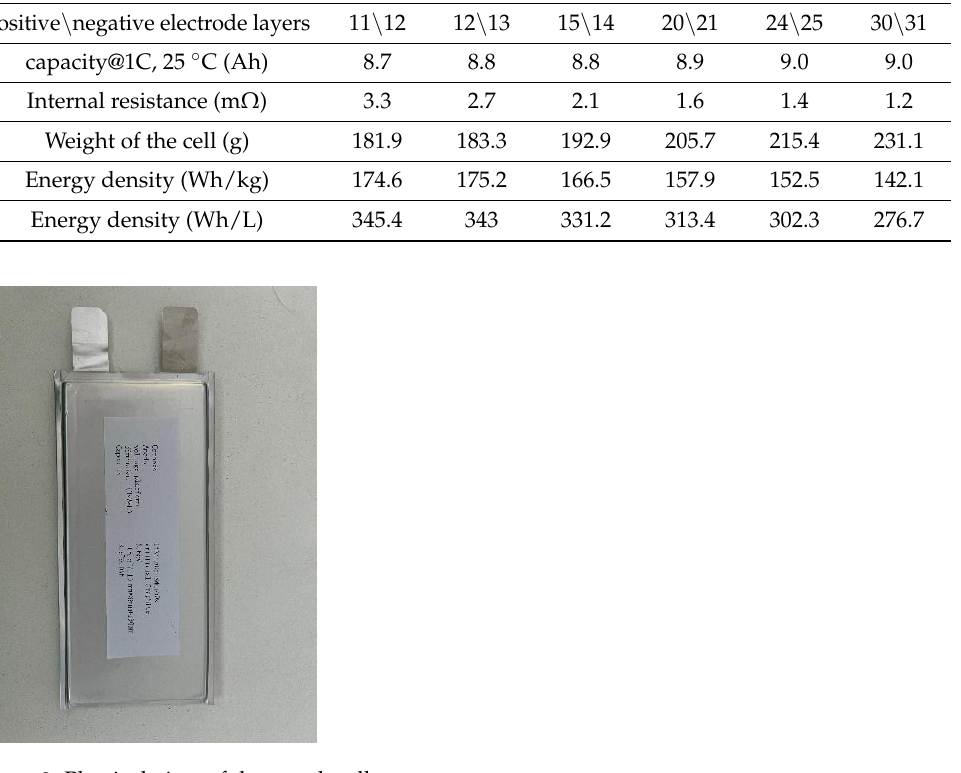
Figure 2. Physical view of the pouch cell.